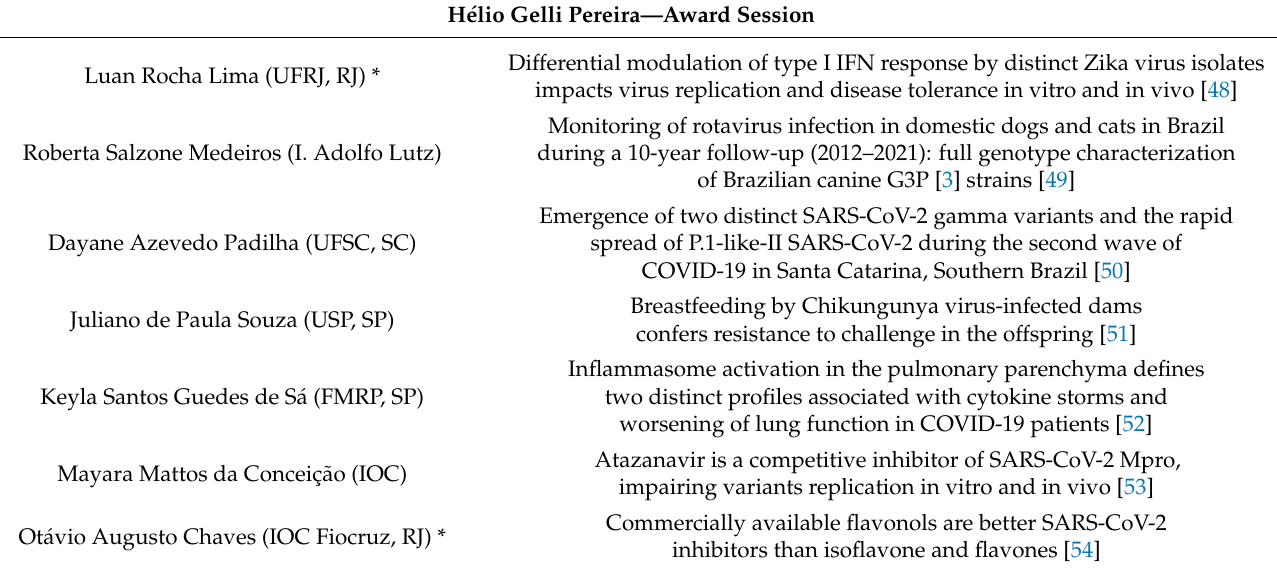
Table 3. Oral presentation during the HGP award